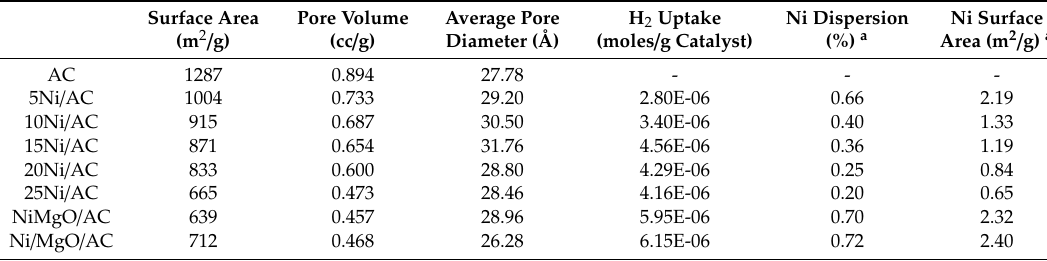
Table 1. Main characteristics of the synthesized